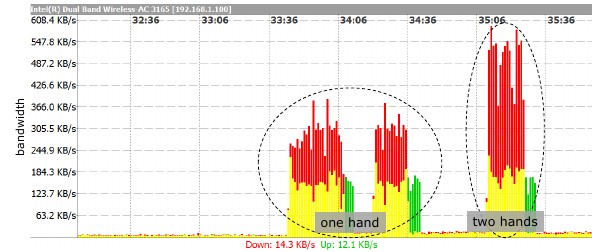
Figure 4. Bandwidth that is measured on a Cardboard client to download leap-frames (red bars) from a computer and to upload leap-frames (green bars) to the Cardboard server in the case of one hand and two hands tracked. Yellow bars represent the overlap between the download and upload.